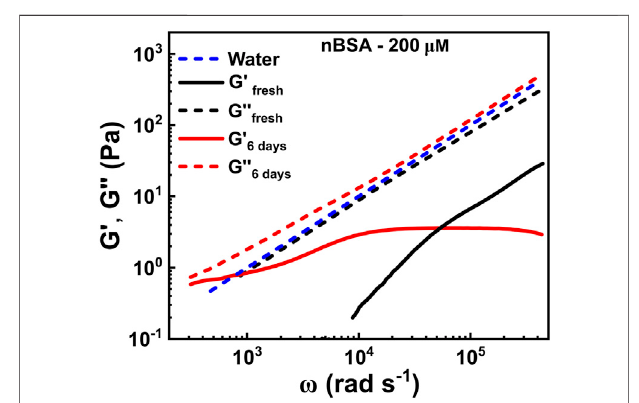
FIGURE 5 | Time evolution of the elastic ( G ′ ( ω )) and viscous ( G ′′ ( ω )) moduliasfunctionsoffrequency,extractedfromtheMSDcurvesin Figure4B of 200 μ M nBSA in solution under aggregation